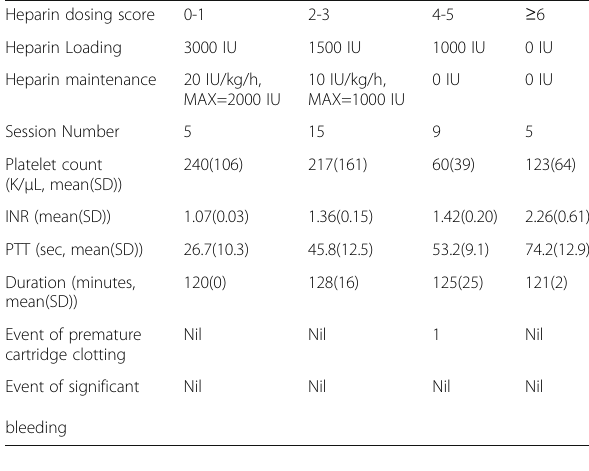
Table 119 (abstract A383). Heparin Dosing Protocol and Session Distribution Heparin dosing